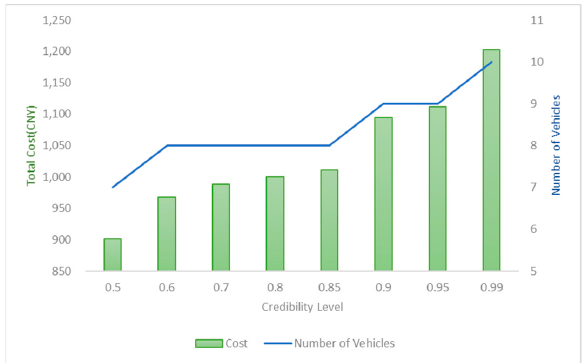
Figure 5. Total Cost and Number of Vehicles under Different Credibility Level 𝛾.